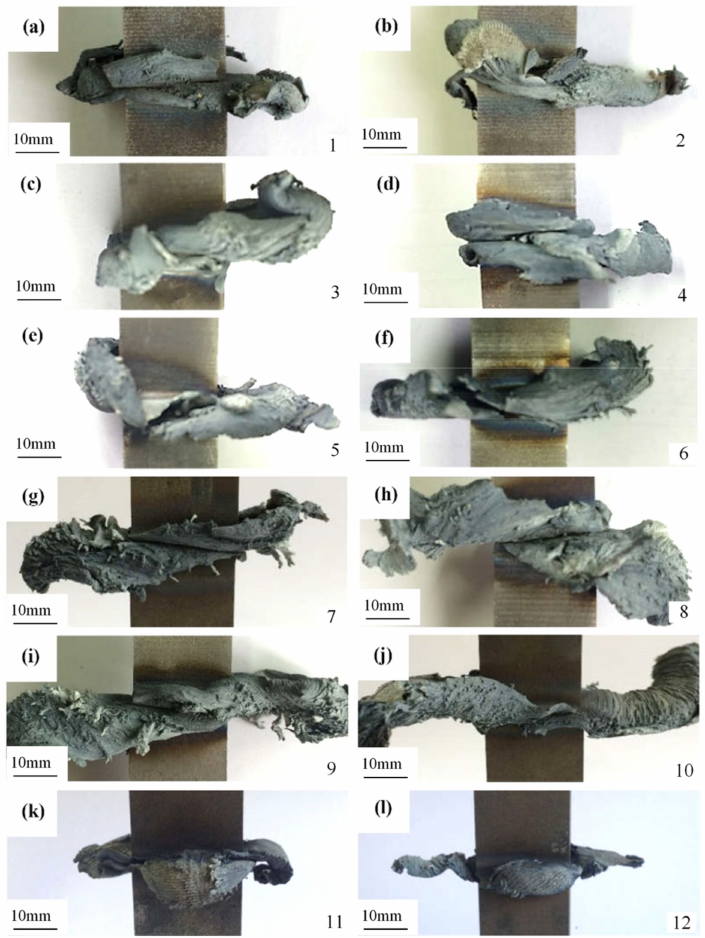
Figure 2. Typical appearance of as-LFWed joints under welding conditions: ( a – l ) correspond to the joint obtained under 1#–12#